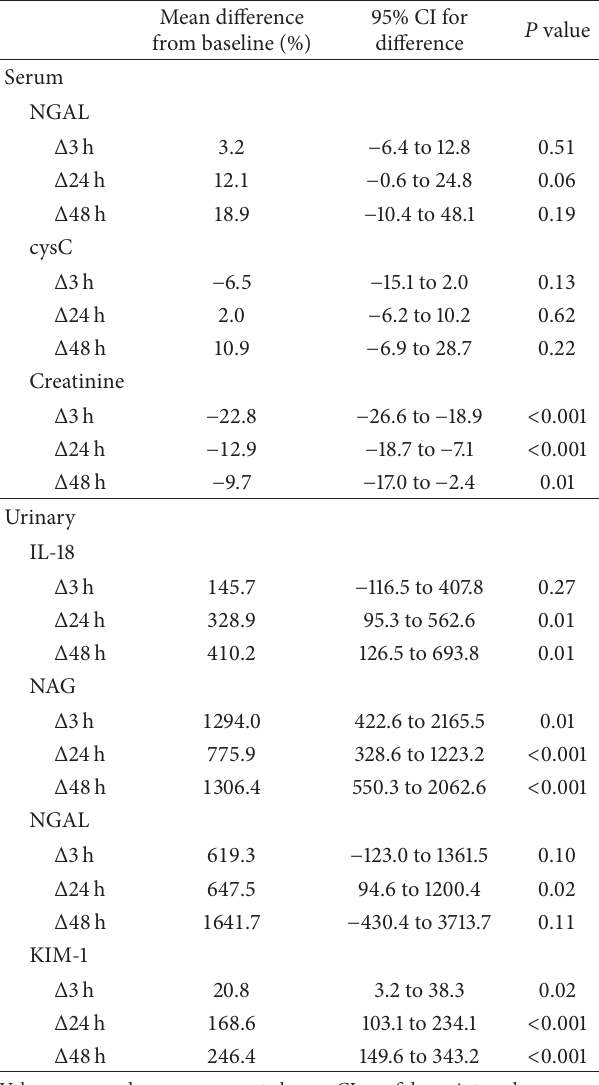
Table3:Meandifferencefrombaselineofvariousbiomarkersbefore and after (3, 24, and 48 hours) surgery, regardless of study